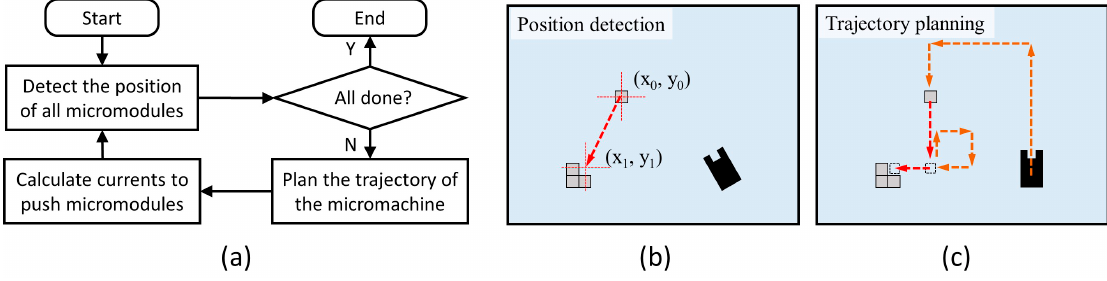
Figure 5. ( a ) Flow chart of micromodules’ assembly. ( b ) Diagram of one micromodule’s position detection. ( c ) Diagram of the micromachine’s trajectory planning.